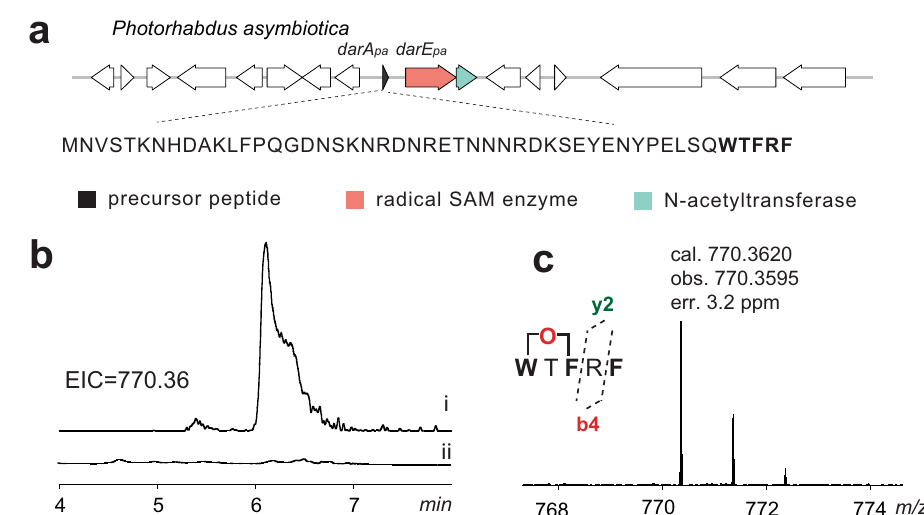
Fig. 7 Production of a monocyclic daropeptide from a cluster IV BGC. a The BGC from P. asymbiotic , showing the genes and the precursor peptide sequence, and the core sequence is shown in bold font. Unlike other daropeptide BGCs, this BGC does not encode the DarBCD transporters but encodes a putative N-acetyltransferase. b The EIC at m/z = 770.36 ± 0.01 (corresponding to the monocyclic pentapeptide containing an ether crosslink) of DarA pa - 1 incubated with (i) the cell lysate of E. coli BL21 or (ii) the boiled cell lysate for 24 h. c HR-MS spectrum of the in vitro obtained monocyclic daropeptide. See Supplementary Figs. 17 – 19 for the data in characterization of the DarA pa -derived